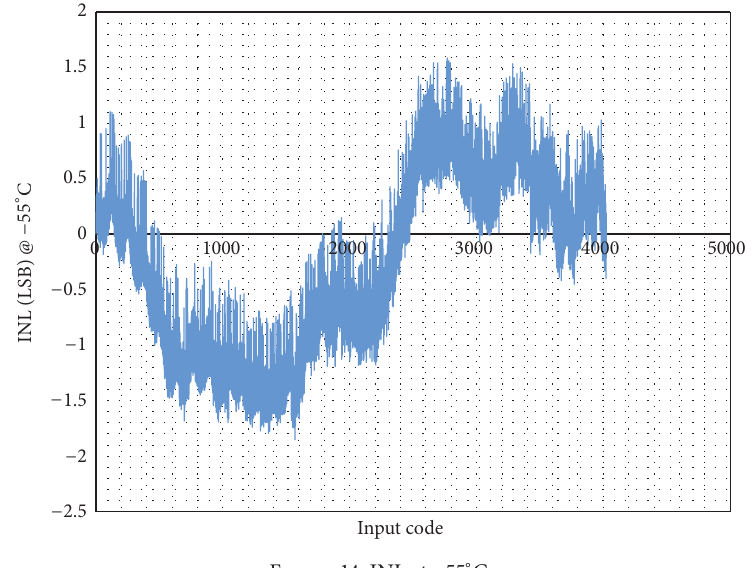
Figure 14: INL at − 55 ∘ C.